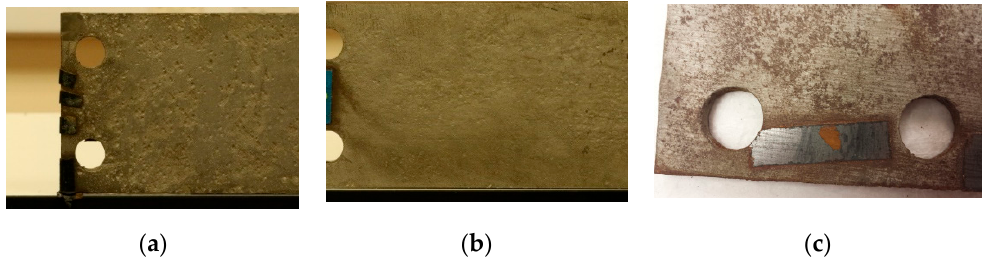
Figure 8. ( a ) High levels of pitting; ( b ) Low levels of pitting; ( c ) Crevice corrosion under marine tape.